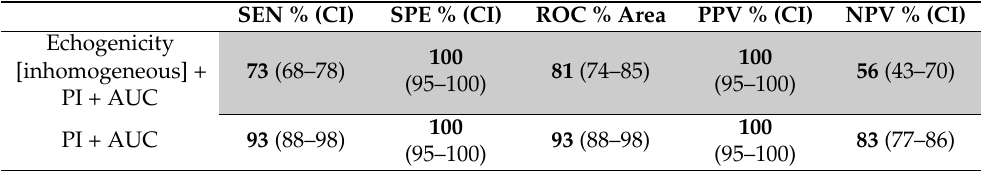
Table 6. Diagnostic performance of the combined best parameters (SEN: Sensitivity; SPE: Specificity; ROC: Receiver Operating Characteristics; PPV: Positive Predictive Value; NPV: Negative Predictive Value; PI: Peak Intensity; AUC: Area Under the